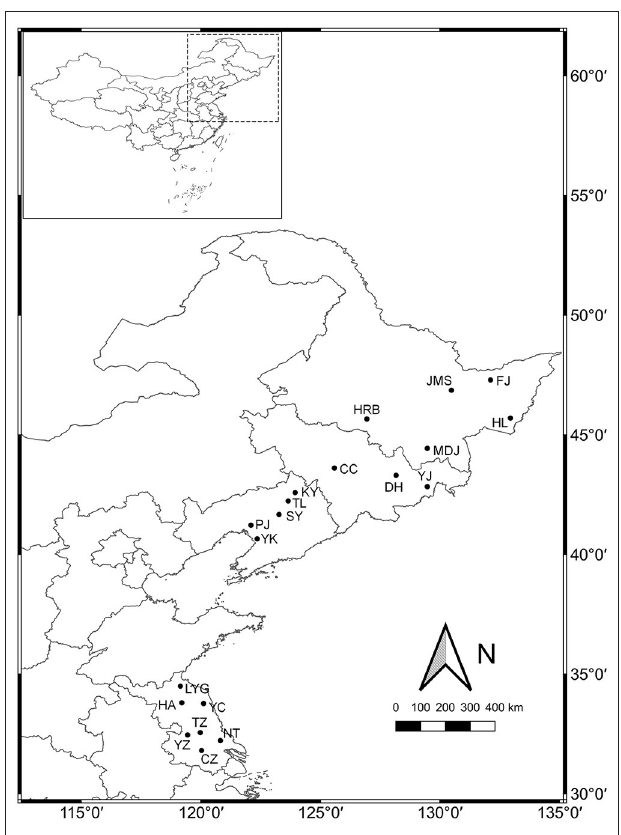
FIGURE 1 | Sampling sites for 20 weedy rice populations investigated in northeastern and eastern China.